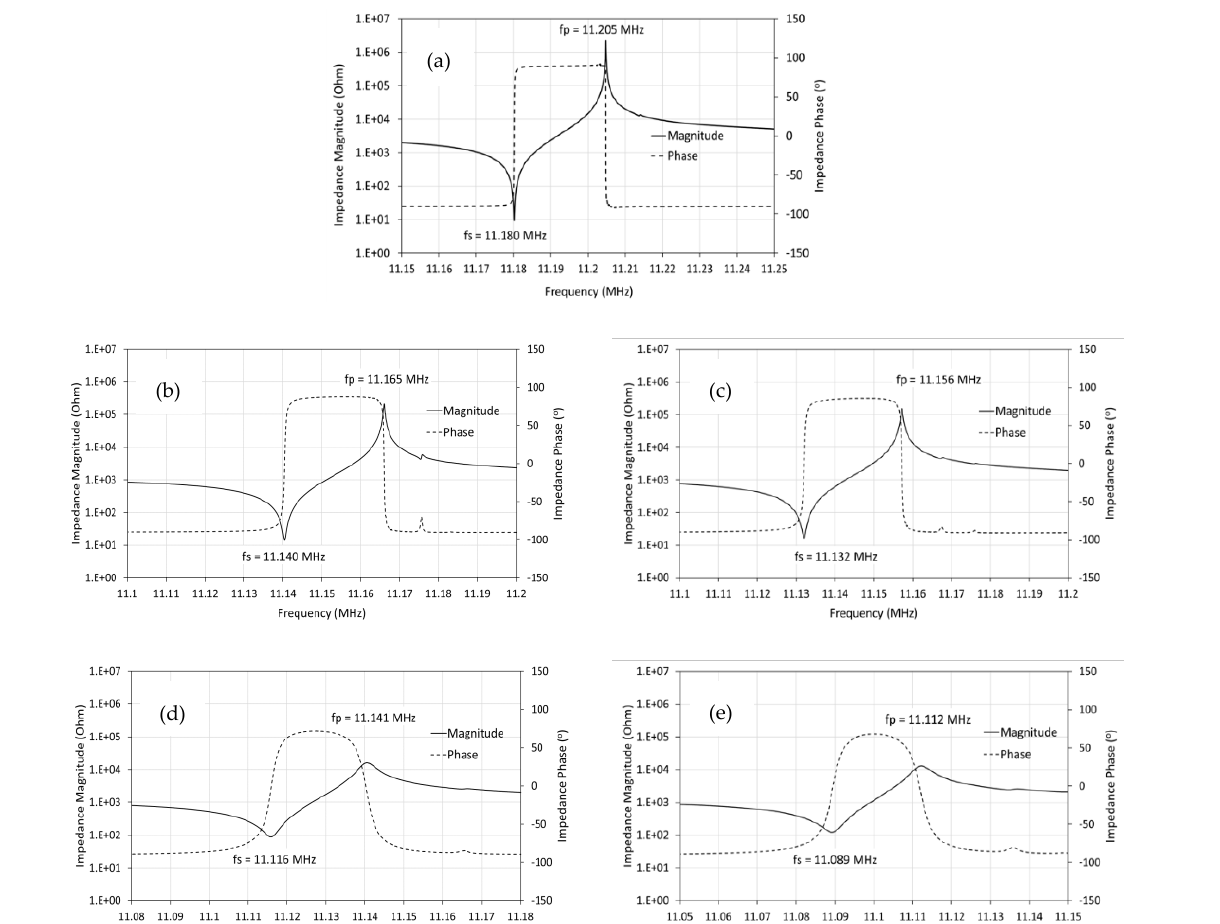
Figure 4. The effect of deposition time on the impedance magnitude and the impedance phase. ( a ) Untreated QCM; QCM coated with SA film deposited for ( b ) 1 min, ( c ) 2 min, ( d ) 3 min and ( e ) 4 min.